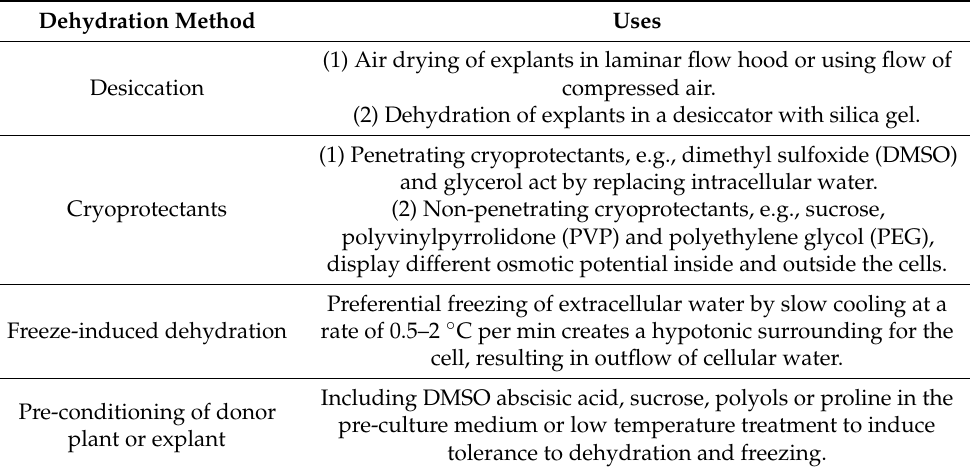
Table 3. Methods to reduce water